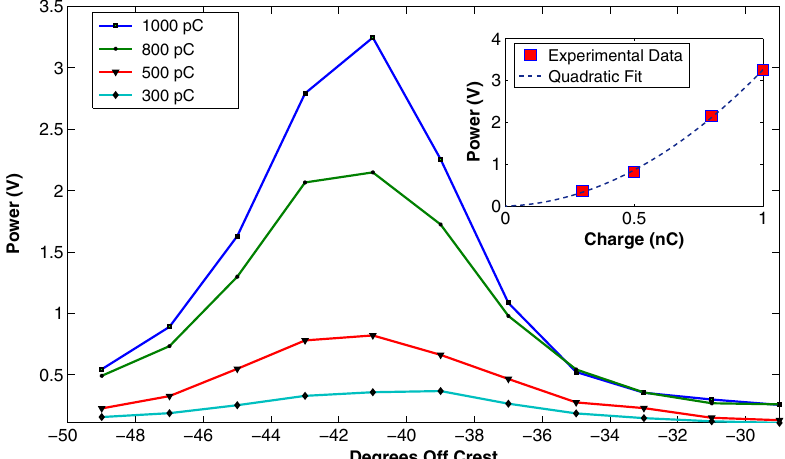
FIG. 3. CSR Power measurement at D3 as a function of 9-cell booster cavity phase. Maximum power is observed at 41 (cid:5) off crest. The inset shows the fit of the CSR power as a function of